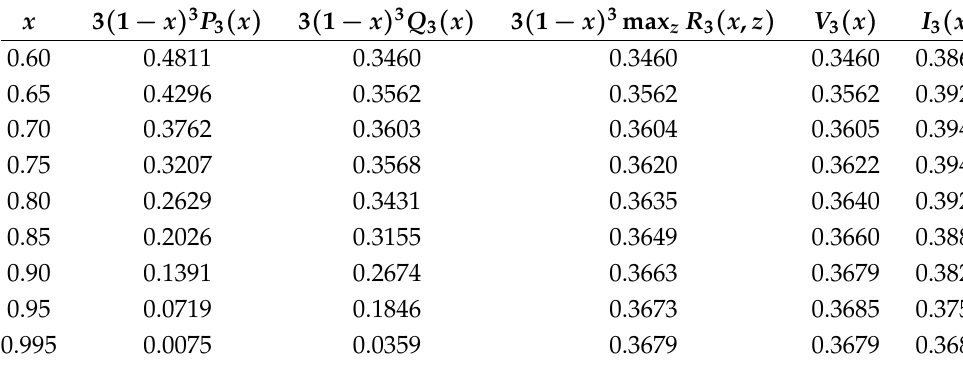
Table 4. Winning probability and bounds for k =